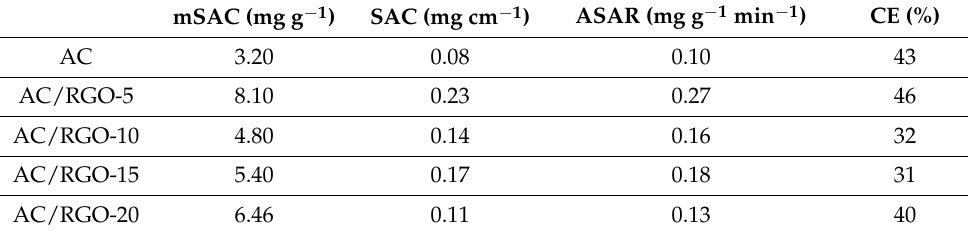
Figure 6. ( a ) Electrosorption curves of AC and AC/RGO-x at 1200 mg. L − 1 NaCl solution under applied voltage of 1.4 V; ( b ) Current response of AC and AC/RGO-x (where x = 5 wt% RGO) at 1.4 V; ( c ) maximum salt adsorption (mSAC) and charge efficiency of AC and AC/RGO-x electrodes. Table 3. CDI operating performance matrices of this experiment at all operating